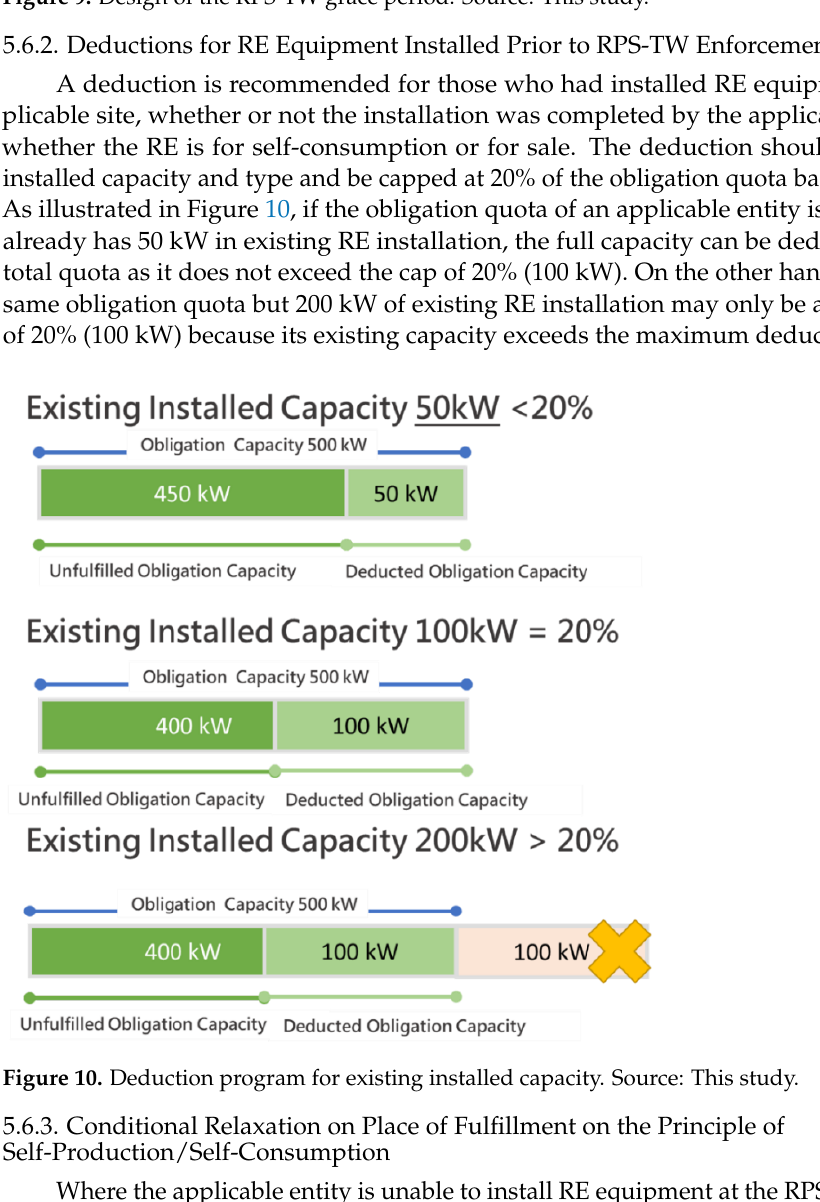
Figure 9. Design of the RPS-TW grace period. Source: This study.